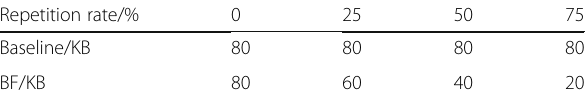
Table 8 Time cost of cryptographic convergence secret key Repetition rate/%